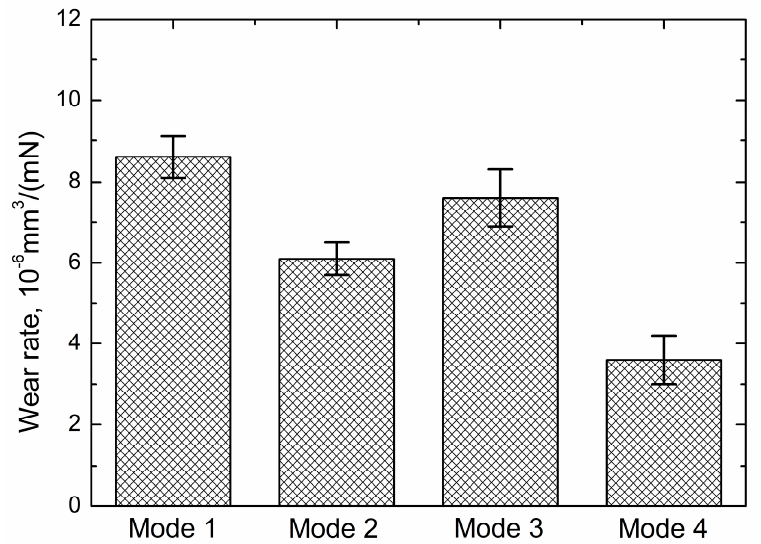
Figure 7. Wear rate of the Ti-Al-Ta-N coatings obtained in different sputtering modes measured after 100 m sliding.